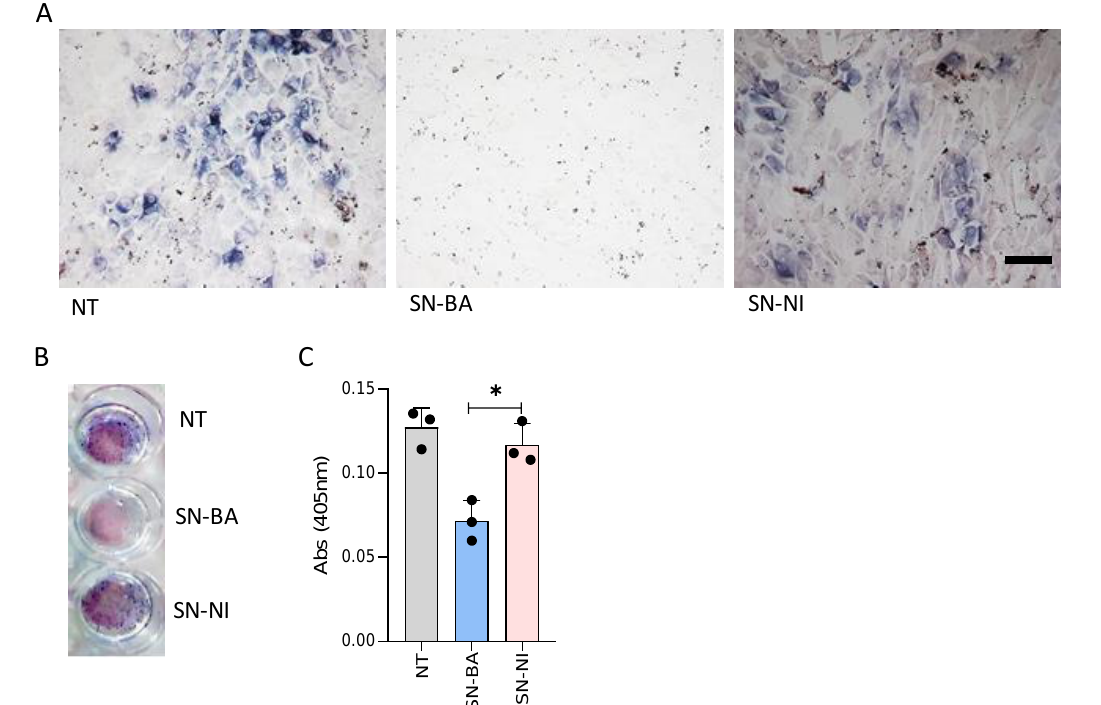
Figure 1. B. abortus -infected adipocytes inhibit osteoblast differentiation. Pre-osteoblasts were differentiated in the presence of culture supernatants from B. abortus -infected adipocytes at multiplicity of infection (MOI) 100 (SN-BA) or culture supernatants from non-infected adipocytes as control (SN-NI). Scale bar: 50 µ m. Alkaline phosphatase (ALP) activity was revealed by staining with BCIP-NBT solution ( A , B ). Quantification of ALP activity was performed on 2 mg total protein of cell lysates incubated with pNPP for 10 min at 37 ◦ C. The absorbance was measured at 420 nm on a microplate reader ( C ). NT: non-treated. * p < 0.001 vs. cells treated with culture supernatants from non-infected adipocytes (SN-NI).